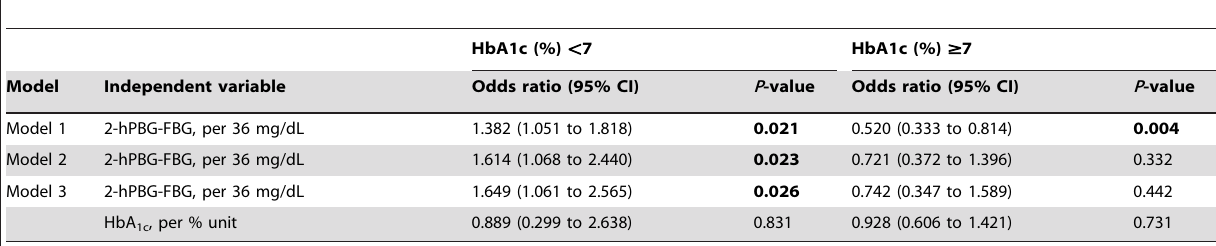
Model 1: not adjusted; Model 2: adjusted for age, gender, BMI, systolic BP and diastolic BP; Model 3: Model 2 plus fasting insulin, cholesterol, triglycerides, smoking and drinking.